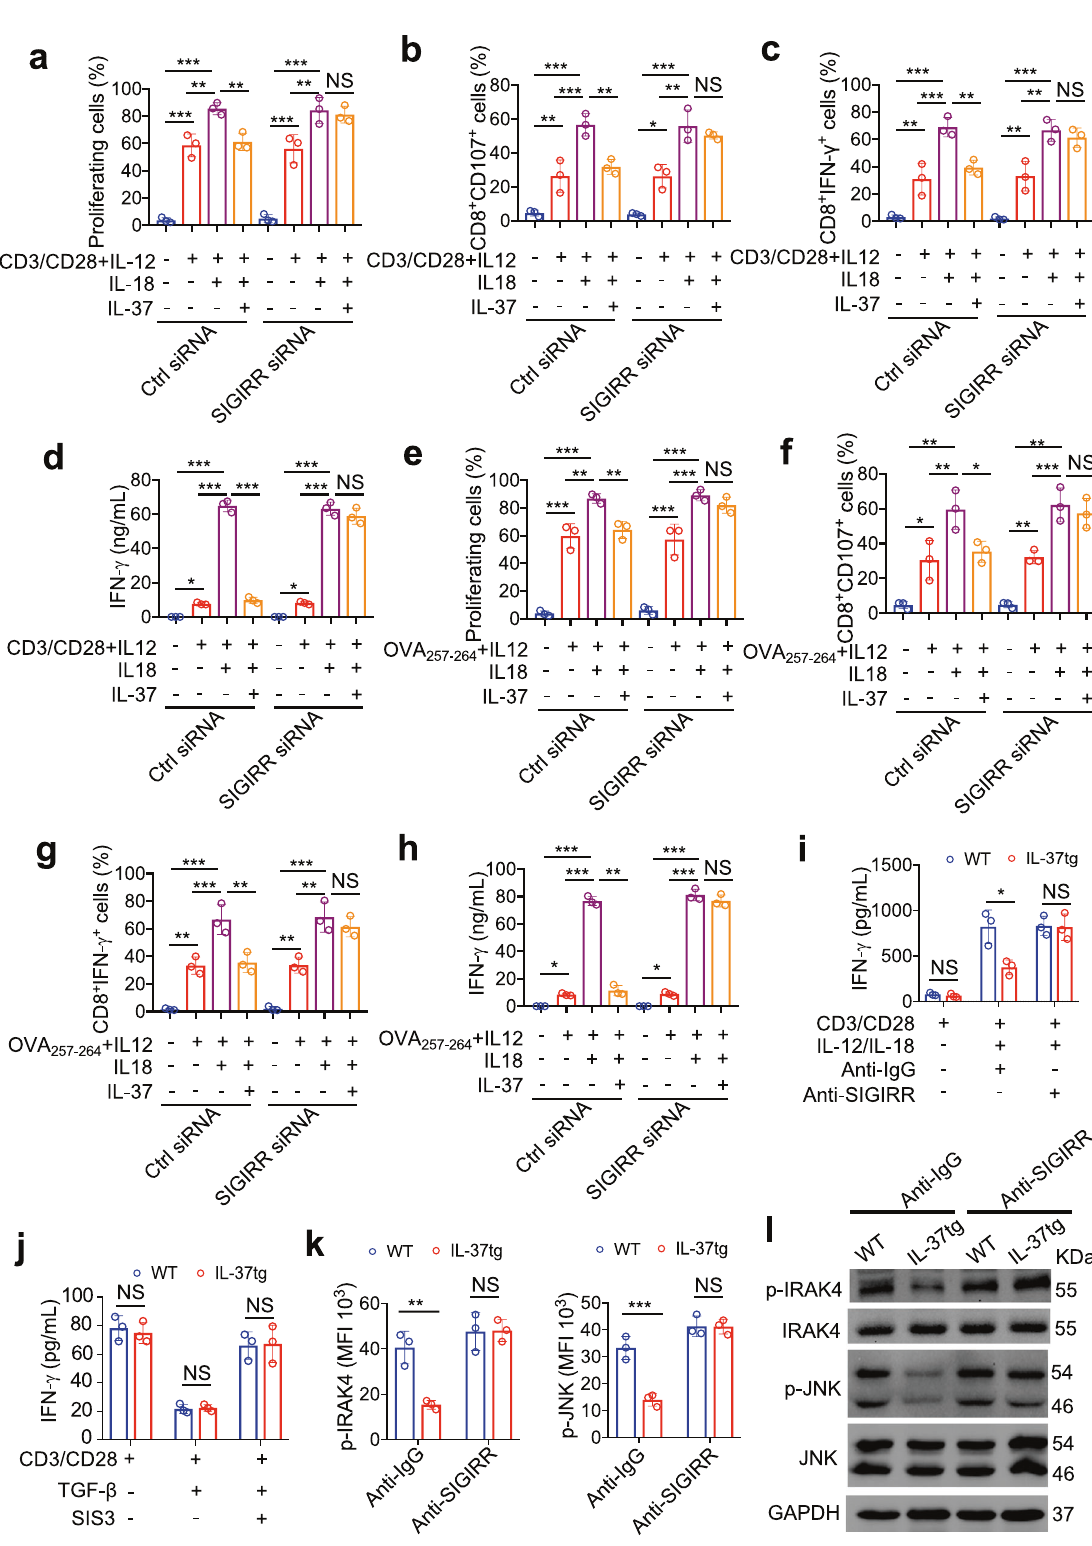
hematology analyzer (Axonlab). OVA-speci fi c T cell receptor- transgenic OT-I mice were obtained from the State Key Laboratory of Biotherapy. Colitis-associated colorectal cancer was induced by injection of mice intraperitoneally as previously reported. 57 IL-37tg and WT